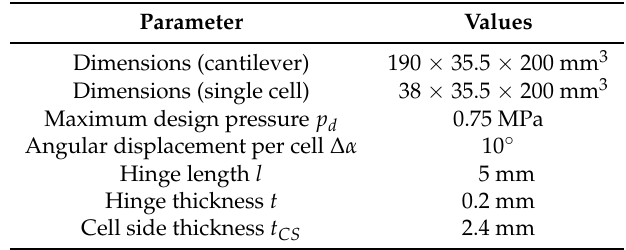
Table 1. PACS design parameters.